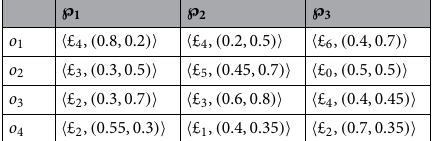
Table 4. Normalized decision matrix provided by d 1